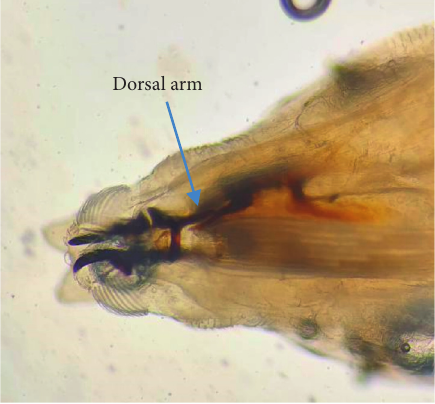
Figure 4: Arms of cephaloskeleton.